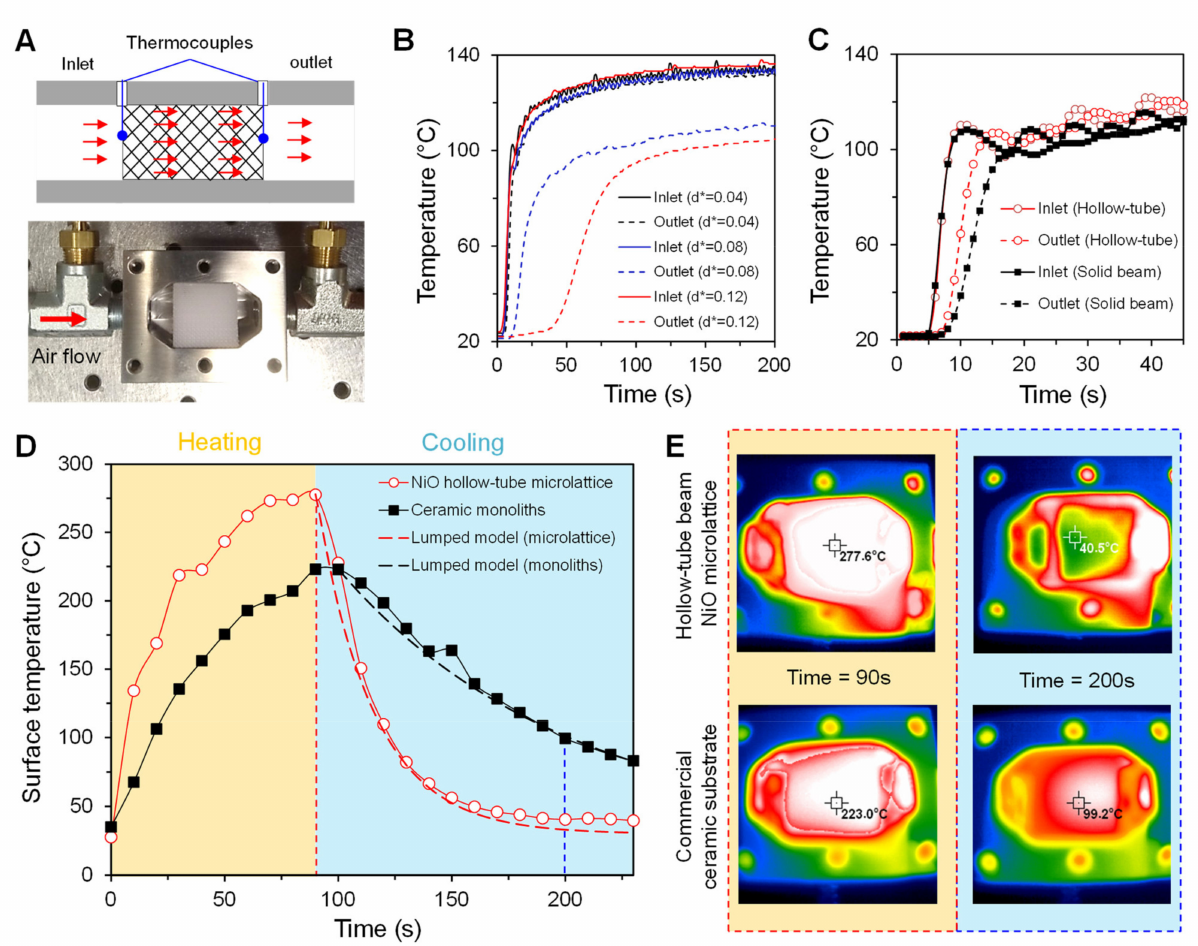
Figure 4. ( A ) Thermal response of microarchitectures with various configurations and constituent materials. ( B ) Polymeric microlattice with solid beams ( d * = 0.04, 0.08, and 0.12), and ( C ) hollow- tube ceramic microlattice and solid Ni-P/polymer composite microlattice ( d * = 0.08 and t * = 0.1). ( D ) Surficial temperature and ( E ) thermal distribution of hollow NiO microlattice and